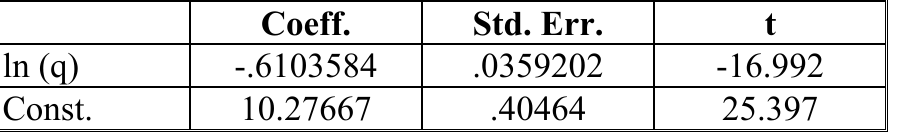
Results of estimating a constrained semilog demand function for tourists from non-African countries Coeff. Std. Err. q